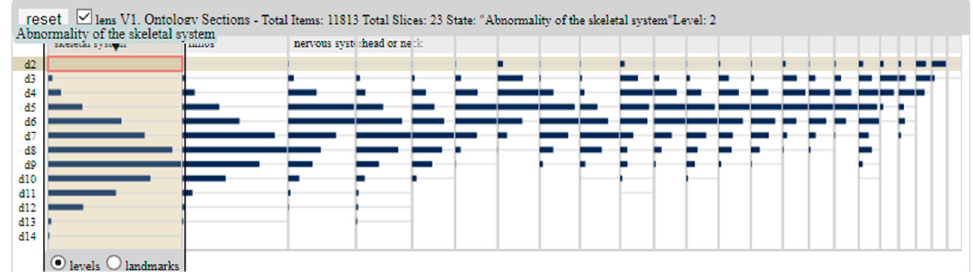
Figure 24. The selection of the “Abnormality of the Skeletal System” section.